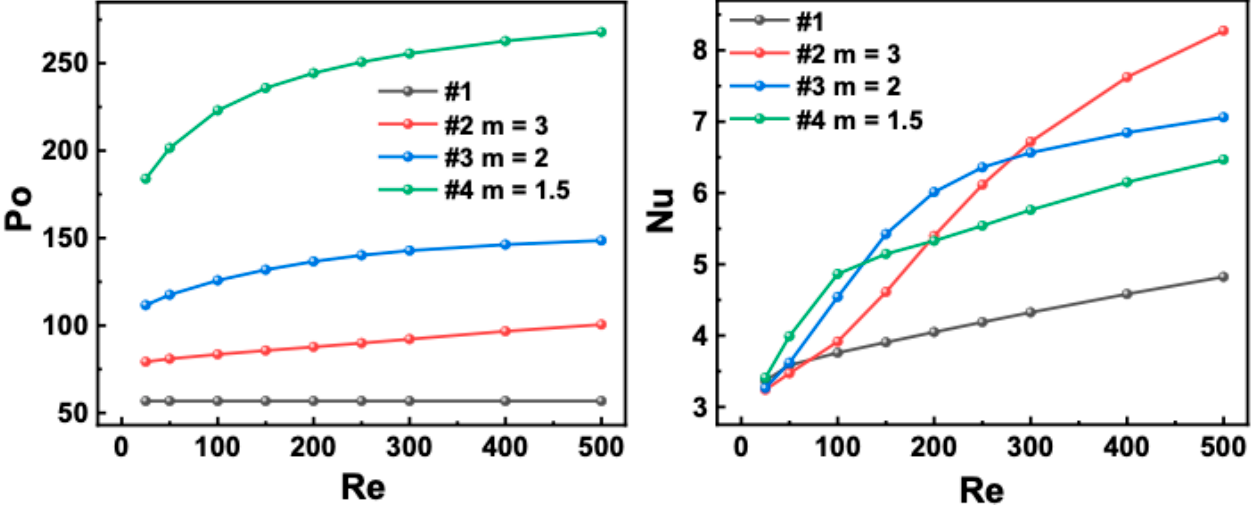
Figure 3. Po and Nu versus Re with different fin aspect ratios (m).